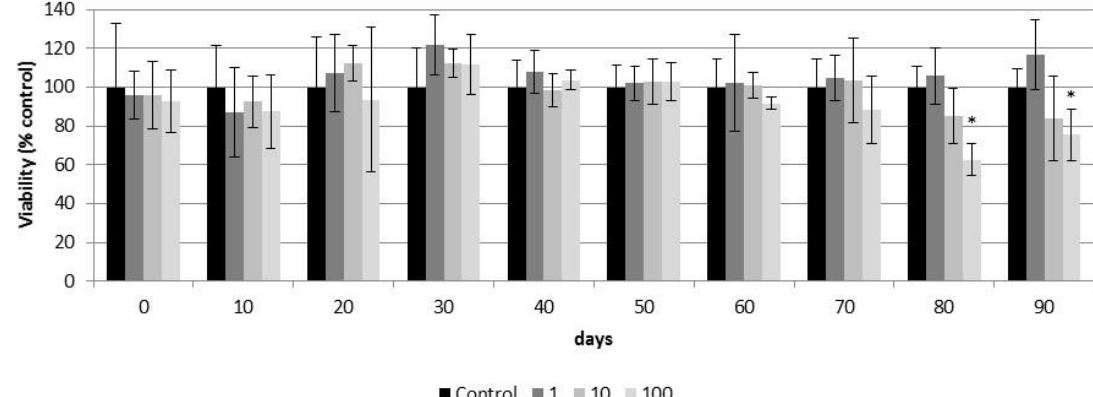
Figure 10. Viability (resazurin assay) of control airway epithelia and airway epithelia exposed for 90 days to different concentrations of CeO 2 -NPs (1, 10, and 100 µg/cm 2 ). Exposures were performed every two weeks for three months. Results are expressed as means ± SD of five replicates per tested condition and one assay ( n = 5). Asterisks indicate significant differences with respect to the untreated control cells ( p < 0.05).